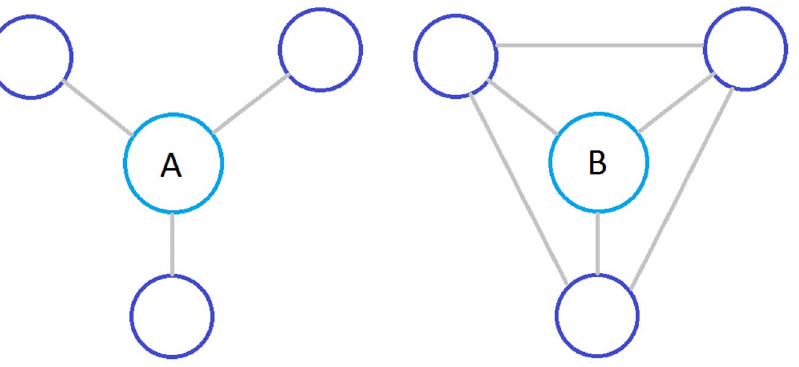
Figure 1. Nodes with same degree may have very different local connectivity. The figure shows two examples where a node with degree 3 may be part of a sparsely-connected star network or a densely-connected